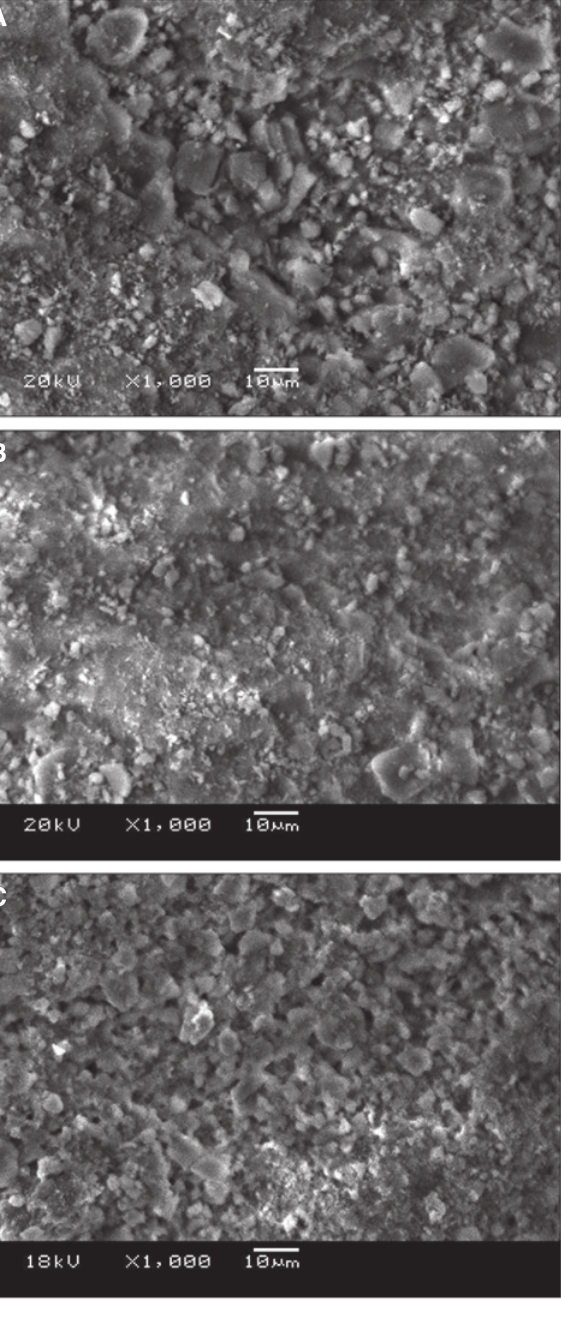
Figure 6: The SEM chart of the bimetallic catalyst MnO